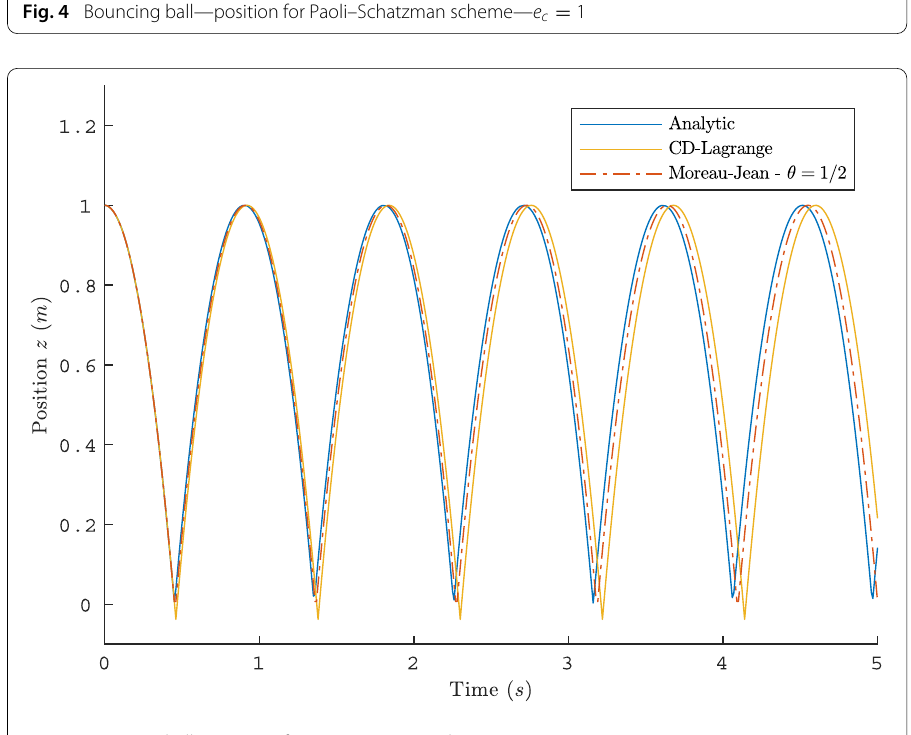
On Fig. 6, we plot position for e c = 0 . 8. Moreau–Jean and CD-Lagrange schemes both pass Zeno’s paradox. On Fig. 7 the restitution coefficient is set to zero. The residual penetration is clearly visible, and with this time-step the residual penetration for CD- Lagrange is higher. But both schemes detect the impact at a different time: at t